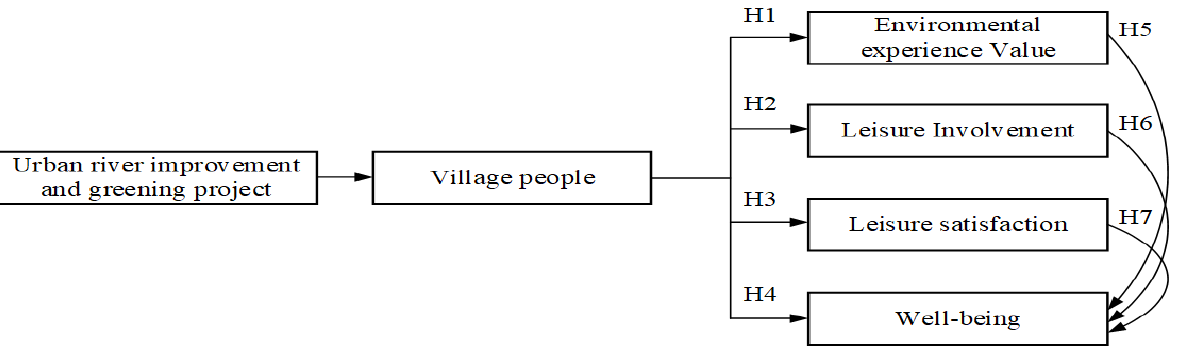
Figure 2. Study framework.